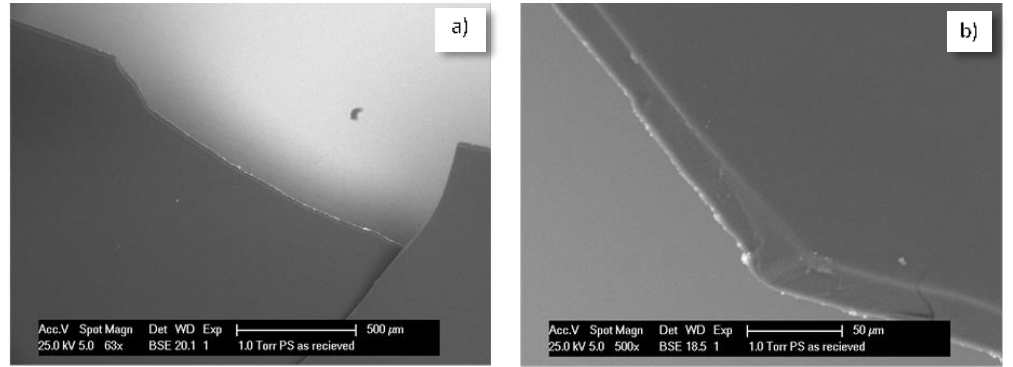
Figure 4. Polyethylene oxide-b-polystyrene coated Calcium sulfoaluminate (PEO-b-PS + CSA) composite—as produced (non-treated) film at magnification 63x ( a ) and 500x ( b ).